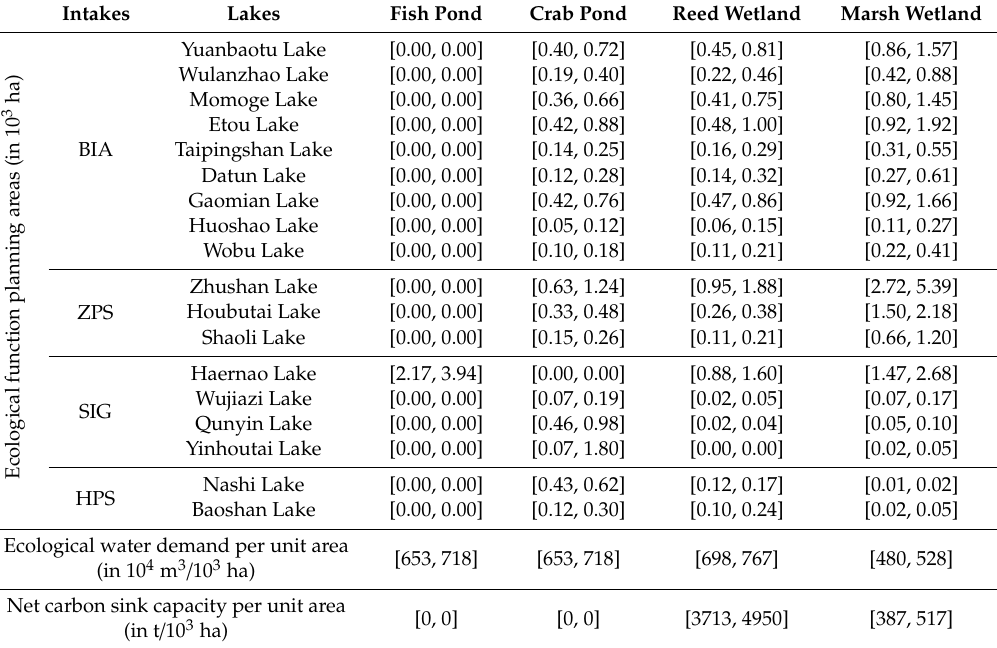
Table 3. Ecological function planning areas, ecological water demand, and net carbon sink capacity per unit area.